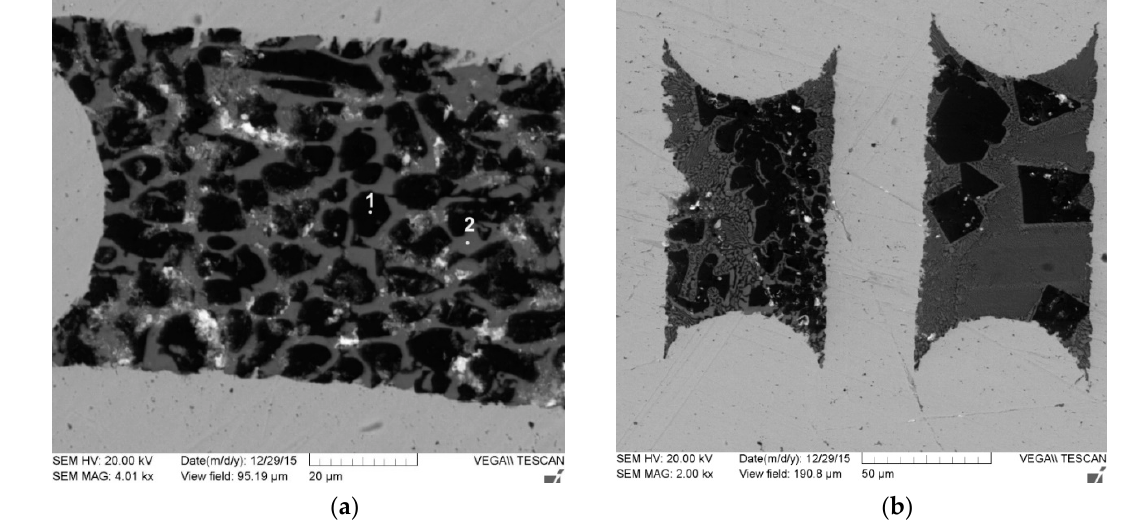
Figure 3. SEM micrographs of the fibers at the top ( a ) and bottom ( b ) of an oxide/molybdenum block. The raw material was sintered at 1250 °C and the crystallization rate of the fibers was 10 mm/min. Here and further on, the fiber crystallization starts at the top. The white spots on the micrographs are polishing defects.